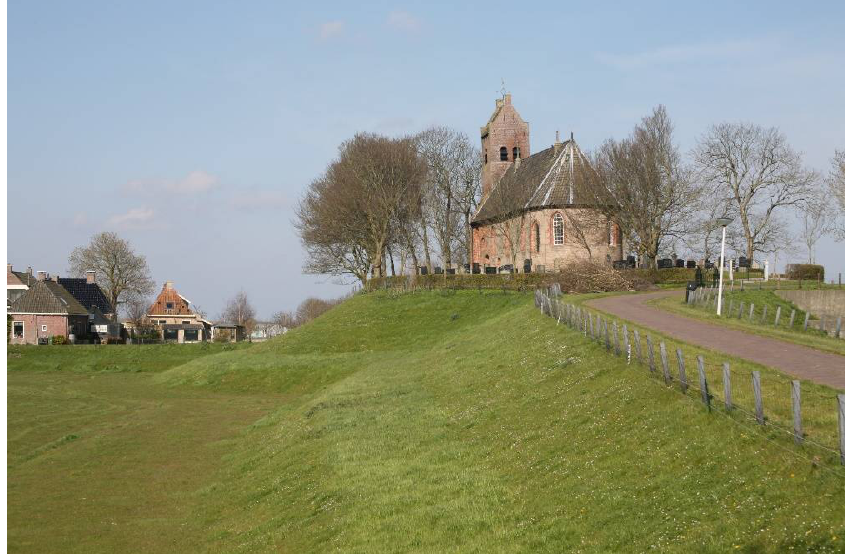
Figure 7. Hegebeintum (Frisia), the 12th-century church sits on top of an 8.8 m high mound, called a “terp” (photo: Regnerus Steensma archive).